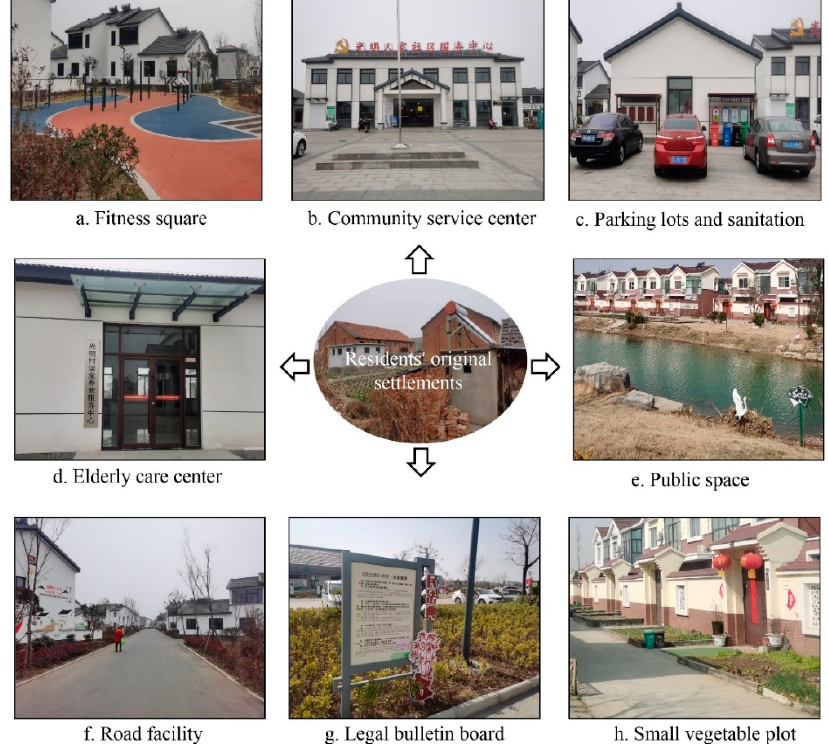
Figure 4. Living facilities and public services in the new settlement. Pictures ( a – h ) show the living facilities and public services in two typical new rural communities (Guangming Family Community and Happy Home Community); the middle picture shows the living facilities in the original rural settlements. Source: The first author took the photographs in 2022. “The greening and housing in the community have been significantly improved compared with the original ones. Now the living conditions are the same as those in the city.